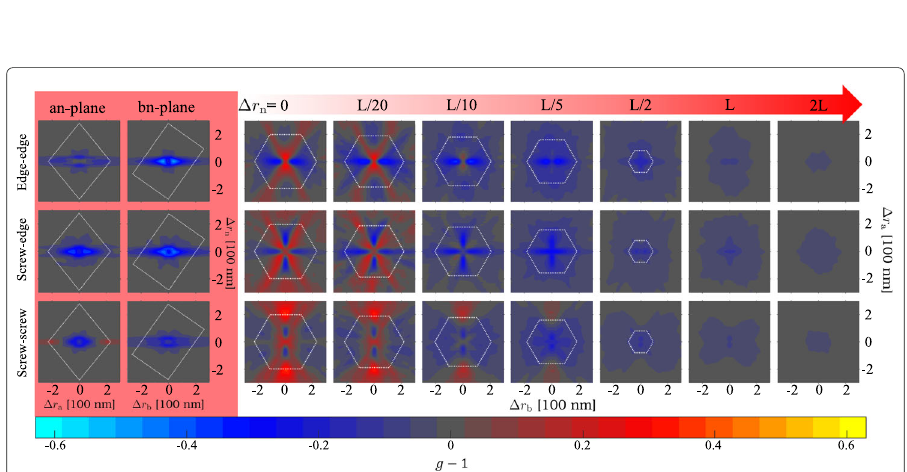
Fig. 6 Out of plane behavior of the self-correlation calculated at 0.3% plastic strain and a convolution length of 162 nm. The first two columns show the behavior for separation distances in planes normal to the slip plane. Columns 3–7 show slices parallel to the slip plane at the indicated values of r n . Taken together, they show that the correlation function is largely relevant only on the slip plane itself, seeing slight anti-correlations for small out-of-plane separation vectors, and rapidly decaying to an uncorrelated state as r n > L (the convolution length). Again, the intersection of the averaging volume with the viewing plane is shown in order to identify features which seem to be influenced by this